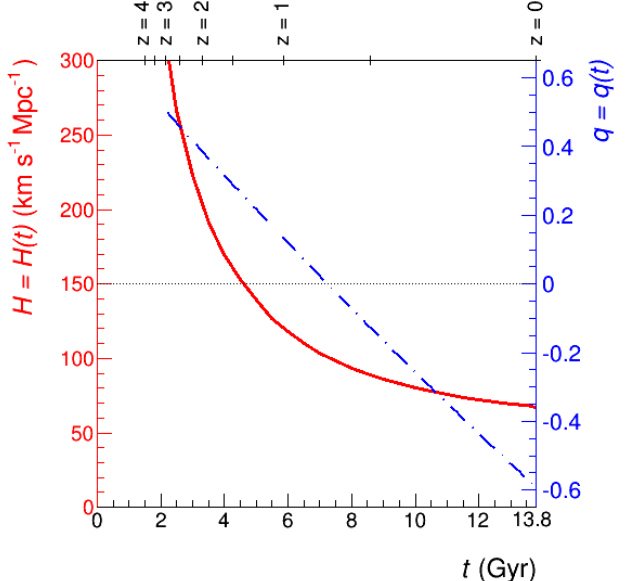
Figure 2. The solid line illustrates the decreasing Hubble parameter H = H ( t ) in time. The dashed- dotted line shows the behavior of the deceleration parameter defined by q = − 1 − ˙ H / H 2 . In the lower horizontal axis we see time in Gyr since the Big Bang, and the upper horizontal axis shows the corresponding redshift z